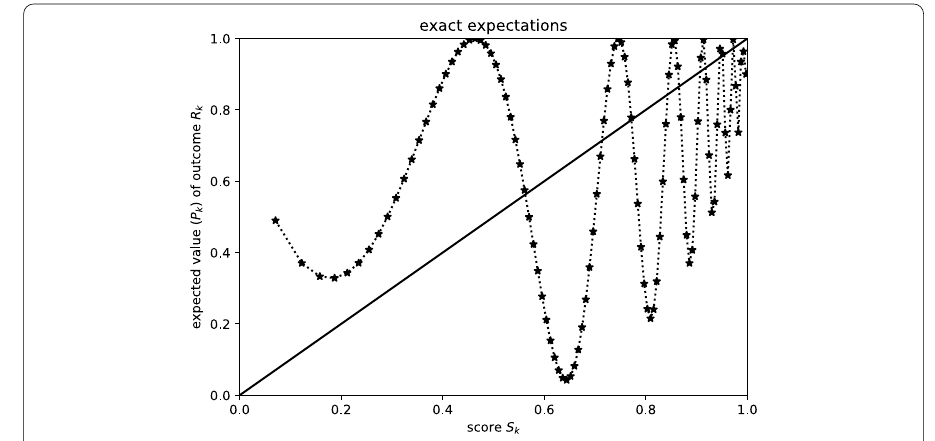
Fig. 45 Ground-truth reliability diagram for Fig.